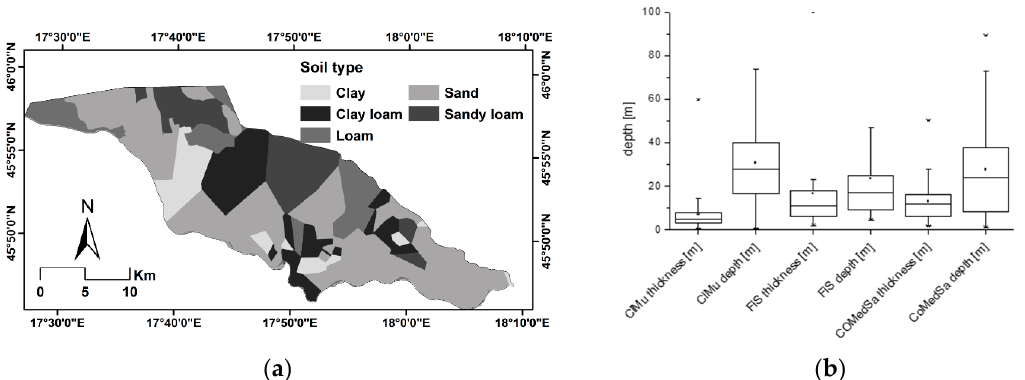
Figure 2. ( a ) Spatial distribution of soil textures in the Drava floodplain, ( b ) vertical distribution of sediment textures in the top 100 m. ClMu: clayey mud; FiS: fine sand; COMedSa: coarse to medium